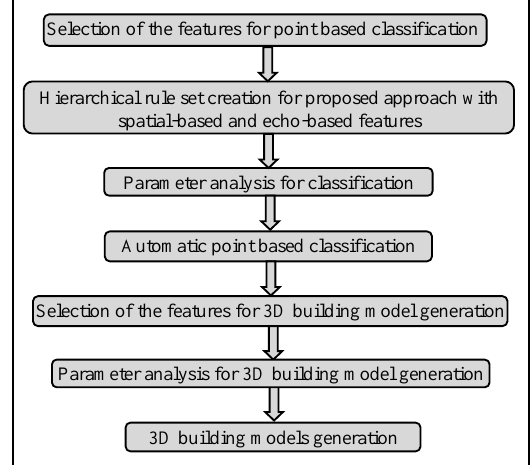
Figure 1. Workflow of the proposed 3D building models generation